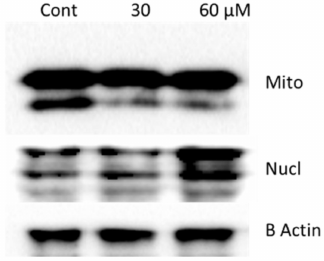
Figure 9. Oroxyquinone caused the nuclear localization of AIF: PC3 cells were treated with PBS (Cont), 30 and 60 µ M oroxyquinone, and incubated for 24 h. The cells were lysed, and the cellular fractions were separated. The AIF in the mitochondrial (Mito) and nuclear (Nucl)-enriched fractions was detected by Western blotting. An increase in AIF localization to the nucleus was observed in 60- µ M treated cells compared to the control. A subsequent decrease in the AIF concentration in the mitochondria was also observed accordingly.